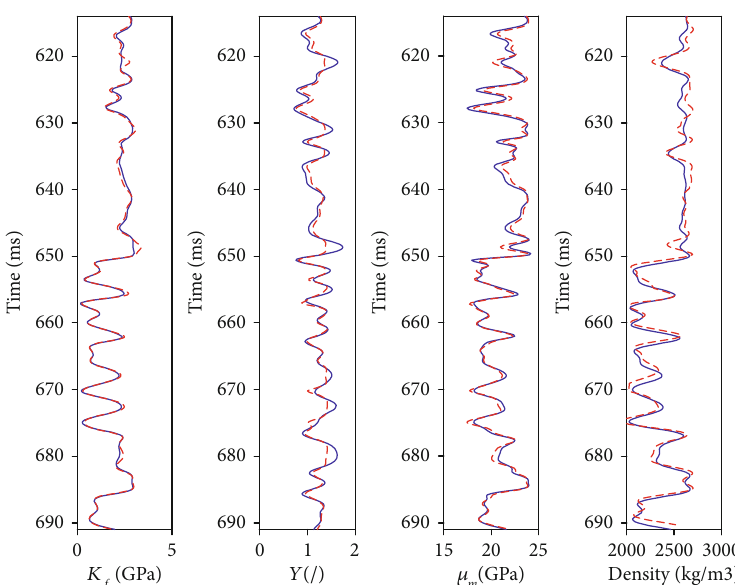
Y , μ f , m , and density (dashed line) from the synthetic noise-free angle gather and their true